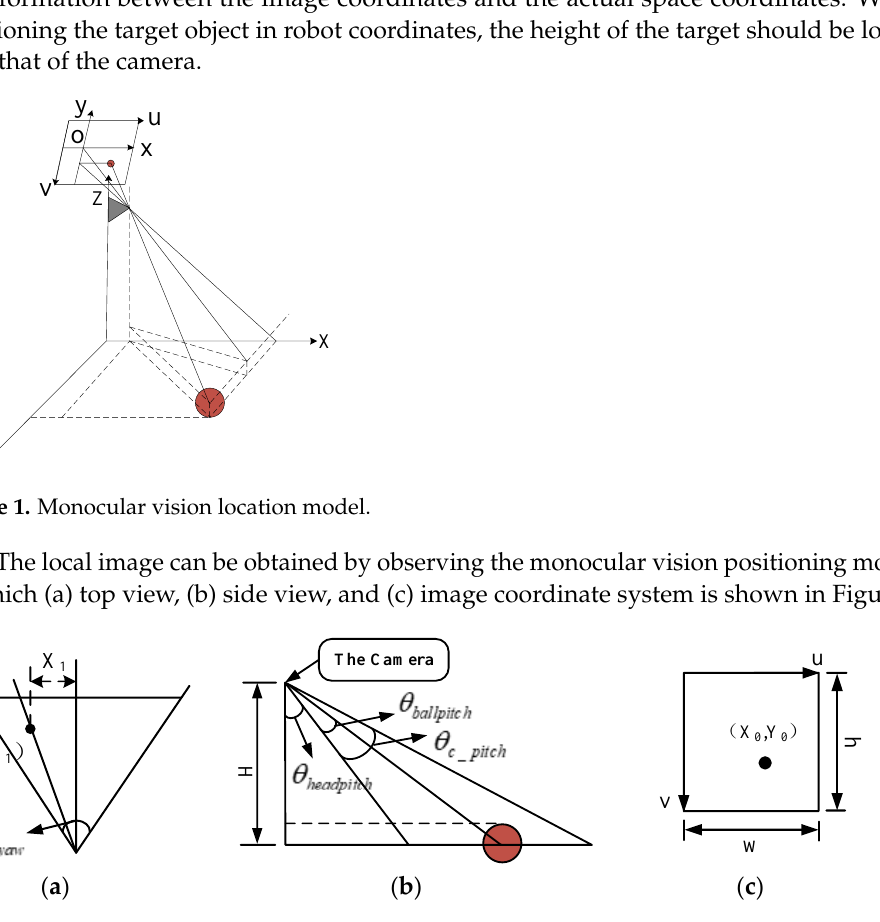
Figure 2. Local image of monocular vision location model: ( a ) vertical view; ( b ) side view; ( c ) image coordinate system.